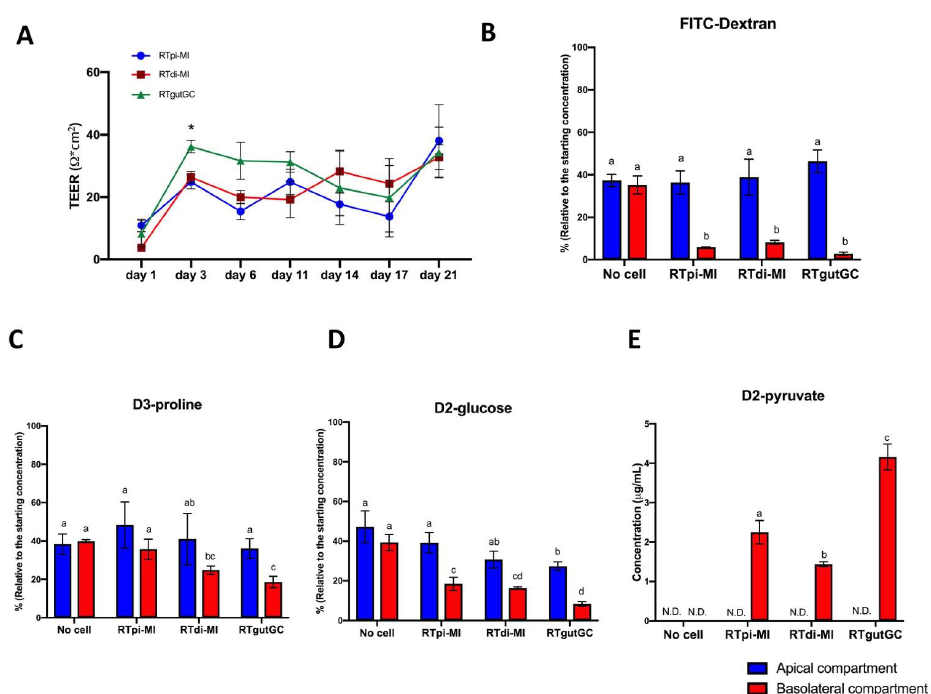
Figure 3. RTpi-MI, RTdi-MI and RTgutGC cell lines were able to constitute an intact and functional epithelial barrier. ( A ) Transepithelial electrical resistance (TEER) measured over 21 days of culture on a permeable PET membrane. Statistical significance for p < 0.05 is indicated as asterisk (*). ( B ) FITC-Dextran concentration ( µ g/mL) measured in the apical and basolateral compartments of the transwell after 24 h incubation. ( C ) D3-proline concentration ( µ g/mL) measured in the apical and basolateral compartments of the transwell after 24 h incubation. ( D ) D2-glucose concentration ( µ g/mL) measured in the apical and basolateral compartments of the transwell after 24 h incubation. ( E ) D2-pyruvate concentration ( µ g/mL) measured in the apical and basolateral compartments of the transwell after 24 h incubation without or with cells (N.D., not detected). Data in Figure ( A ) were obtained from 3 independent experiments run in parallel, whereas data in figures ( B – D ) were from 3 independent experiments. All data are shown as the mean ± SD. Different superscript letters indicate statistical